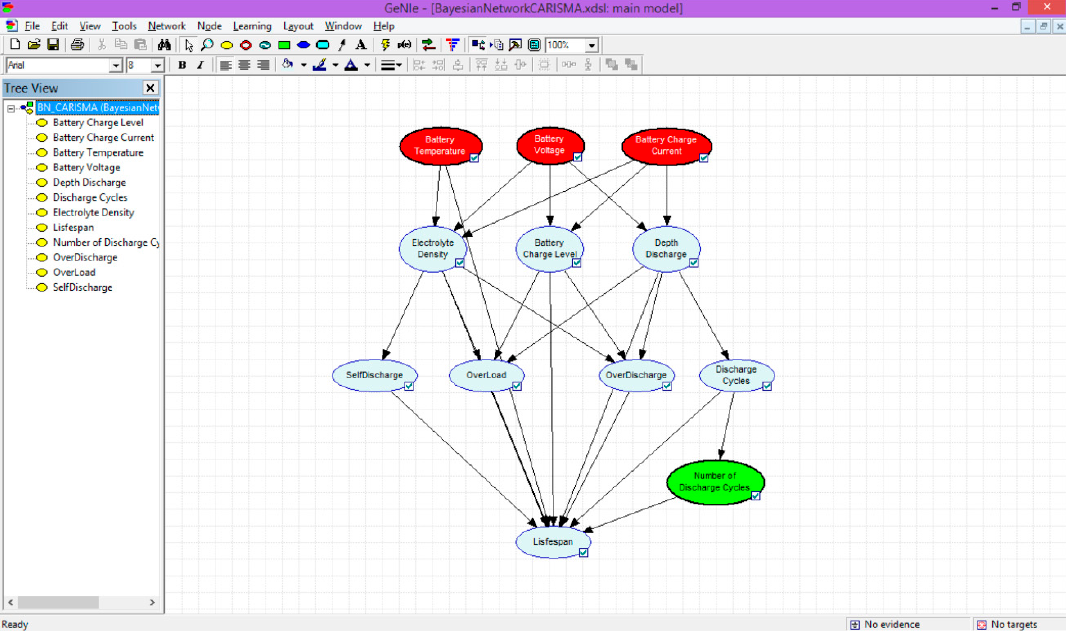
Figure 4. Bayesian network to calculate the battery lifespan in GeNIe.